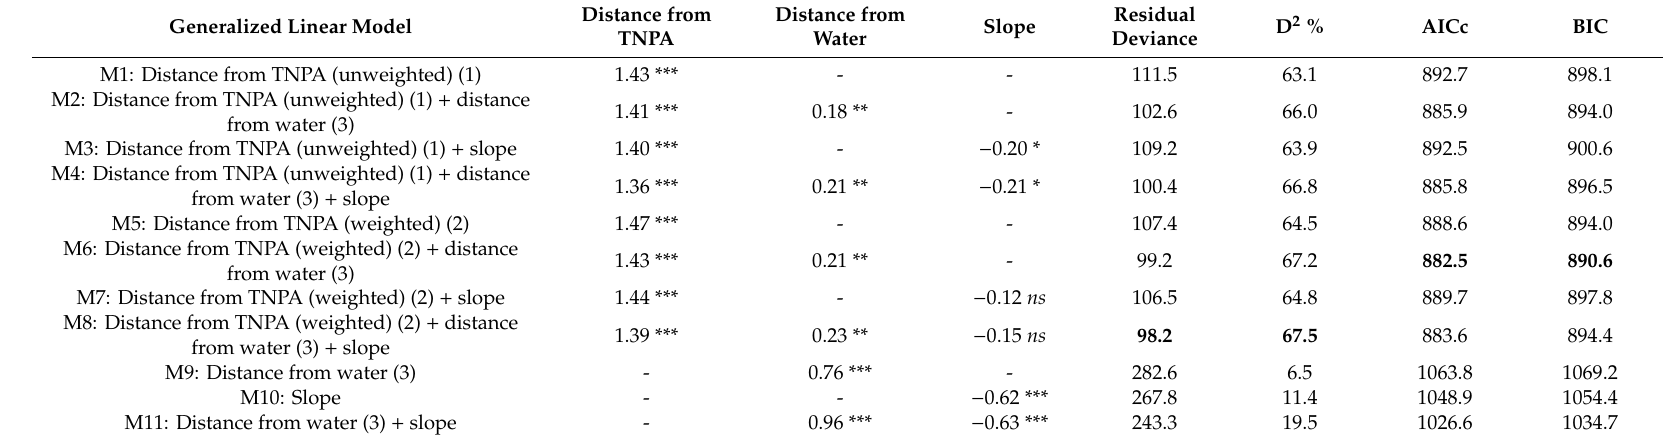
Table 2. Summary of generalized linear models (GLMs) of sheep site use intensity by di ff erent sets of explanatory variables. Numbers in brackets refer to formulas in the Methods section. β coe ffi cients and significance levels are provided for each variable as results of the related GLM. Goodness of model fit (best values are highlighted in bold): D 2 , explained deviance; AICc, Akaike’s information criterion with small-sample correction; BIC, Bayesian information criterion. ***, p <